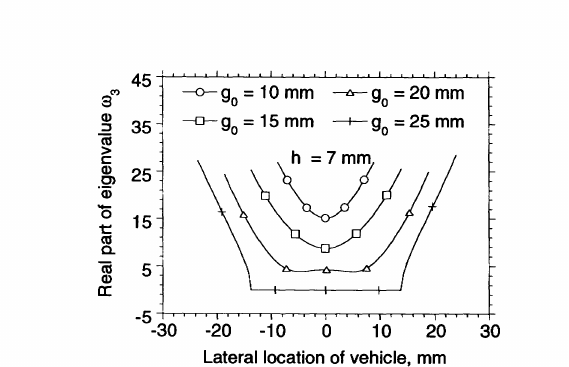
FIGURE 3 Real part of maglev-system eigenvalues vs. lateral location of vehicle, with h = 7 mm and go = 10, 15, 20, and 25 mm (Cai et aI.,